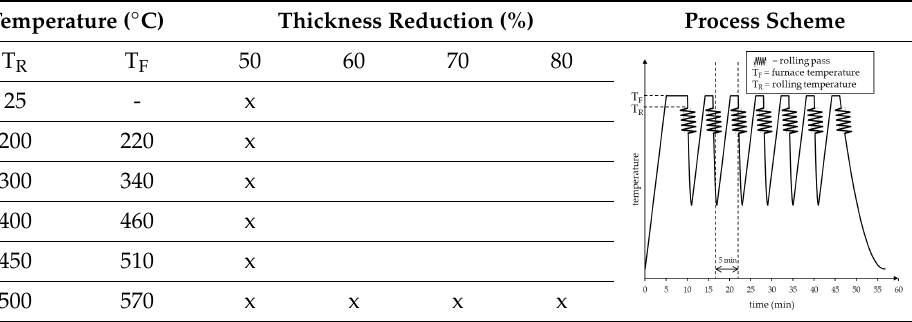
Table 2. Process parameter combinations (marked with an x) and process scheme of warm rolling.